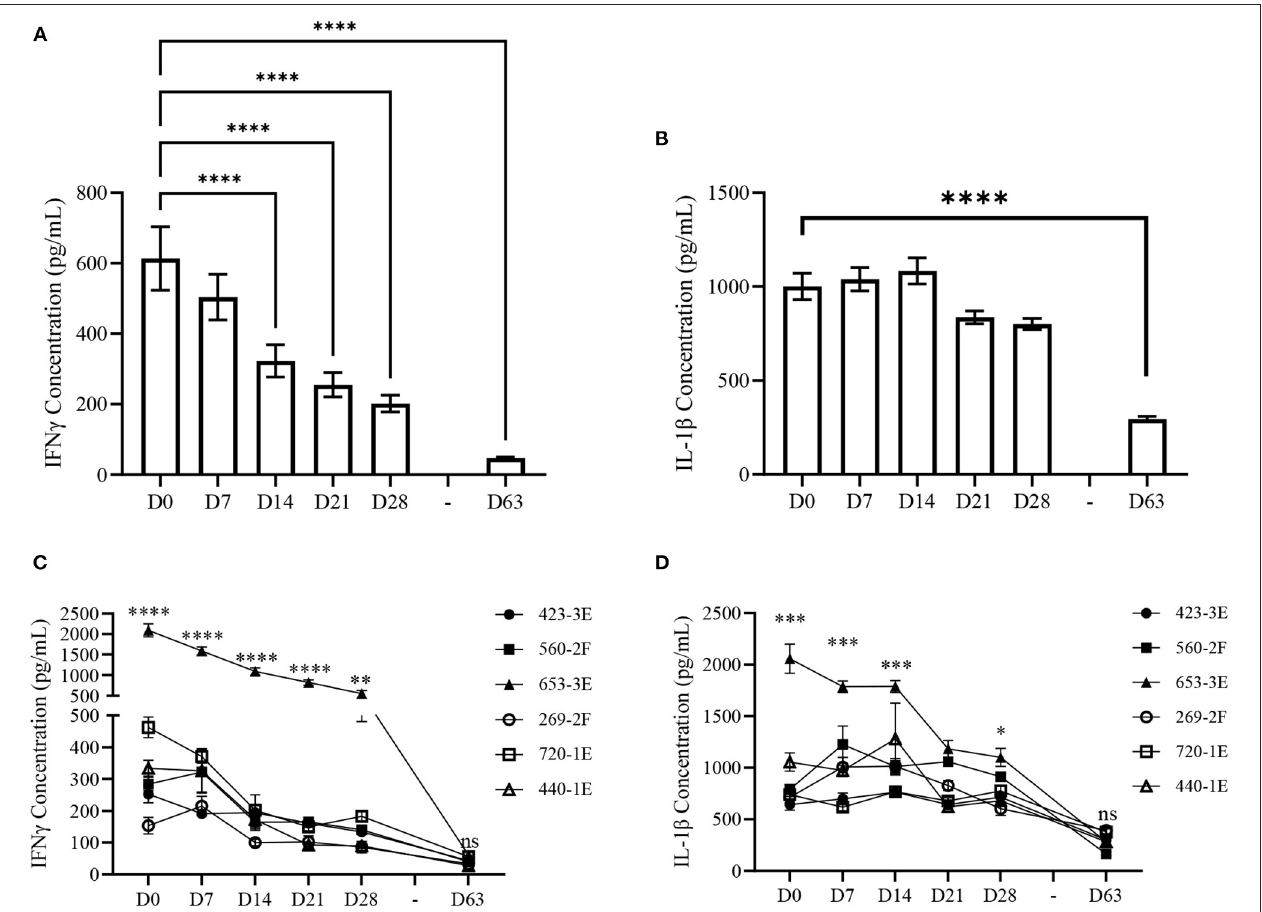
FIGURE 3 | Plasma cytokine concentrations of Trial 2020 piglets from birth (D0) to 63-days of age (D63) at weekly intervals. (A) Mean ( ± SEM) plasma interferon-gamma (IFN γ ) and (B) interleukin 1-beta (IL-1 β ) concentrations measured weekly from piglets within Trial 2020 ( n = 67) from birth (D0) until vaccination (D28) and at 63-days of age (D63). Differences determined using a Kruskal-Wallis one-way ANOVA with Dunn’s multiple comparisons. (C) Mean ( ± SEM) plasma IFN γ and (D) IL-1 β concentrations measured weekly from D0 to D28, and at D63, of Trial 2020 ( n = 67) grouped by the factor “Litter” (423–3E, n = 14; 560–2F, n = 12; 653–3E, n = 11; 269–2F, n = 8; 720–1E, n = 12; 440–1E, n = 10). Differences determined using a two-way mixed effects ANOVA with Tukey’s multiple comparisons. Asterisks designate differences in mean cytokine concentration between litters. Only p -values representing the differences across all multiple comparisons between litters are shown. n.s. p > 0.05; * p < 0.05; ** p < 0.01; *** p < 0.005; **** p <